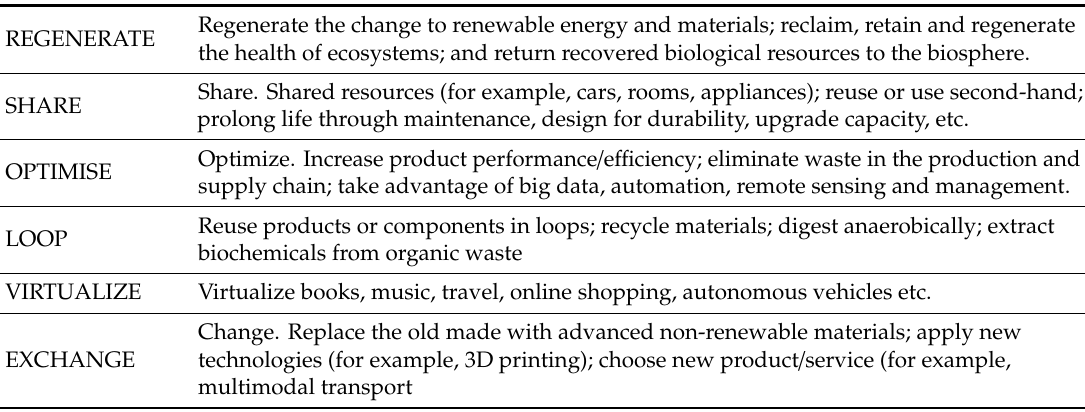
Table 3. The Framework